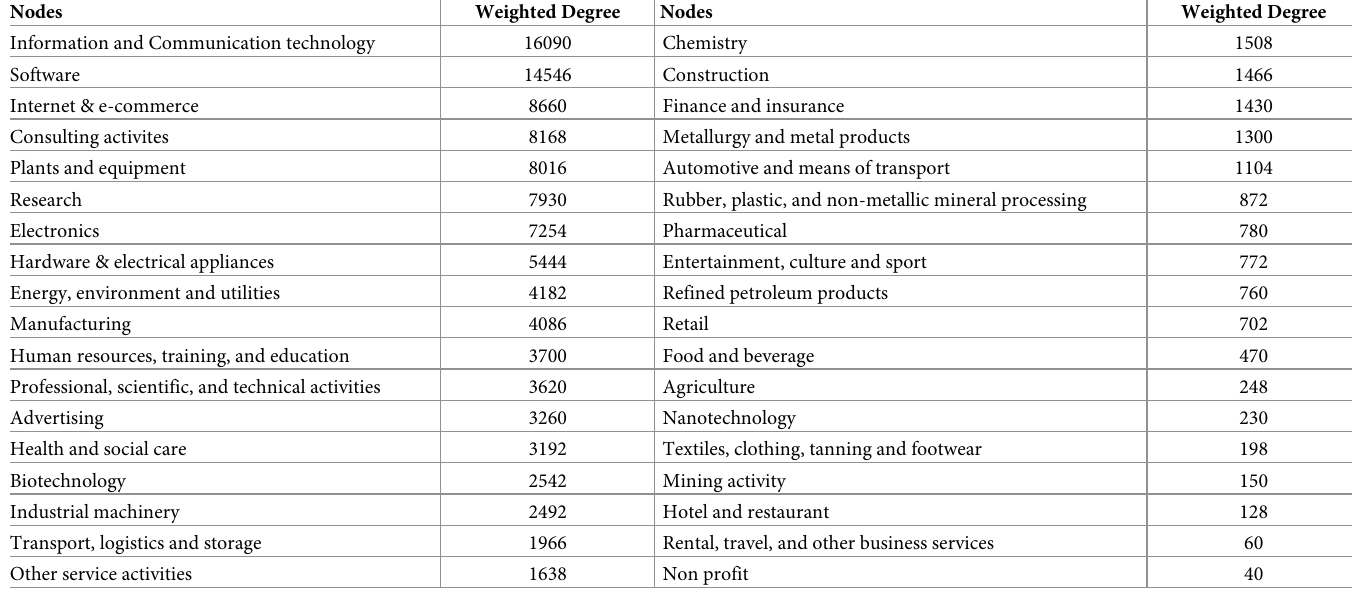
Table 8. The centrality of sectors based on the co-occurrence of competencies (weighted